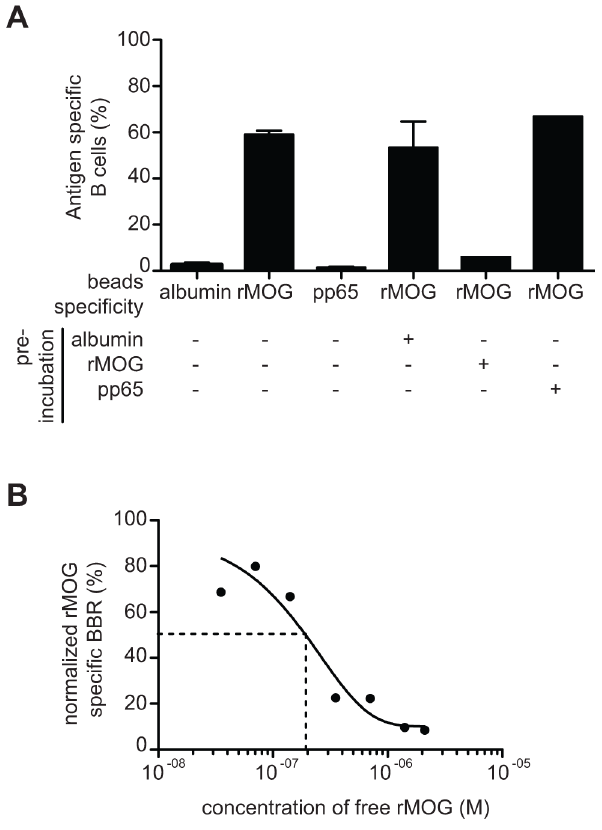
Figure 2. Bead-based method allows the detection of antigen- specific B cells. ( A ) B cells purified from Tg mice were incubated with human albumin, MOG 1–125 or pp65 coated beads and the frequency of antigen specific B cells was quantified. The B cells were preincubated with soluble human Albumin, MOG 1–125 or pp65 before incubation with MOG 1–125 coated beads. Data are presented as mean 6 sem B ). B cells purified from Tg mice were preincubated with increasing doses of soluble MOG 1–125 before incubation with MOG 1–125 coated beads. The experiments were repeated 3 times and similar results were obtained.